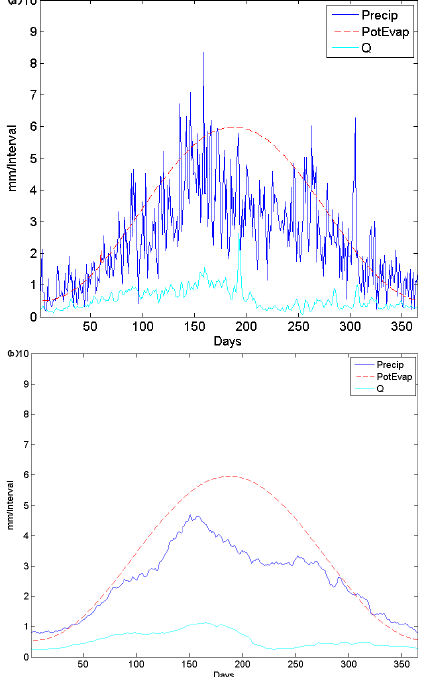
Fig. 1. (a) Daily regime curve, and (b) 30-day moving average, Marais des Cygnes River, near Ottawa, Kansas,